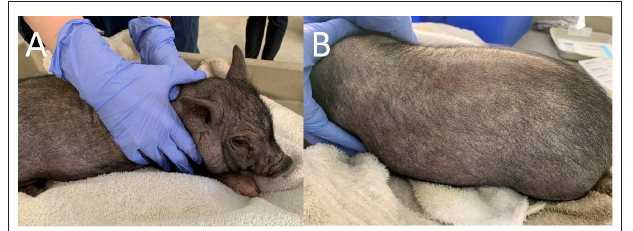
FIGURE 1 | Photographs of the pig taken on initial examination. Note the bilateral excoriations. (A) Right Lateral View. (B) Left Lateral View.